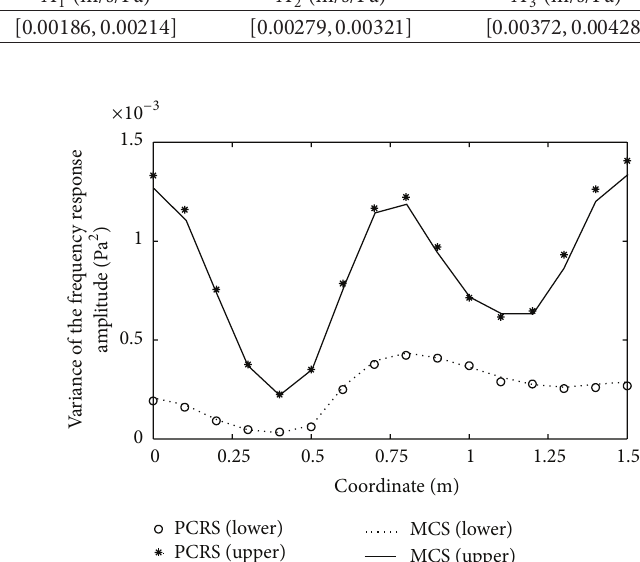
Figure 8: The lower and upper bounds of variance of the frequency response amplitude at uncertain level 15%.